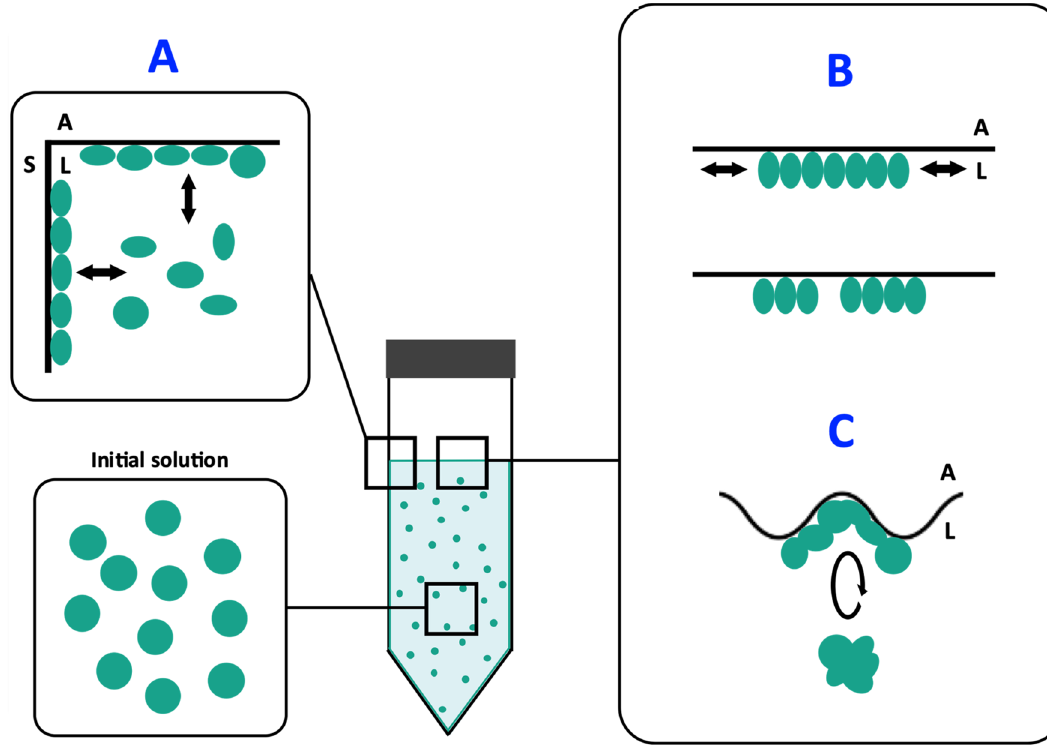
Figure 10 . Model of protein destabilization by contact with plastic surfaces under agitation. ( A ) The affinity of the container surface for unfolded protein destabilizes the protein in solution through a conformational drift. This process is more important in case of fresh A/L and S/L interfaces. ( B ) The destabilized proteins adsorb at the A/L interface. Variations of interface quantity induce compression and decompression forces, promoting protein aggregation. ( C ) Shear forces may facilitate the transfer from and to interfaces in step A and break the protein films formed in step B. Adapted from Sluzky et al. 32